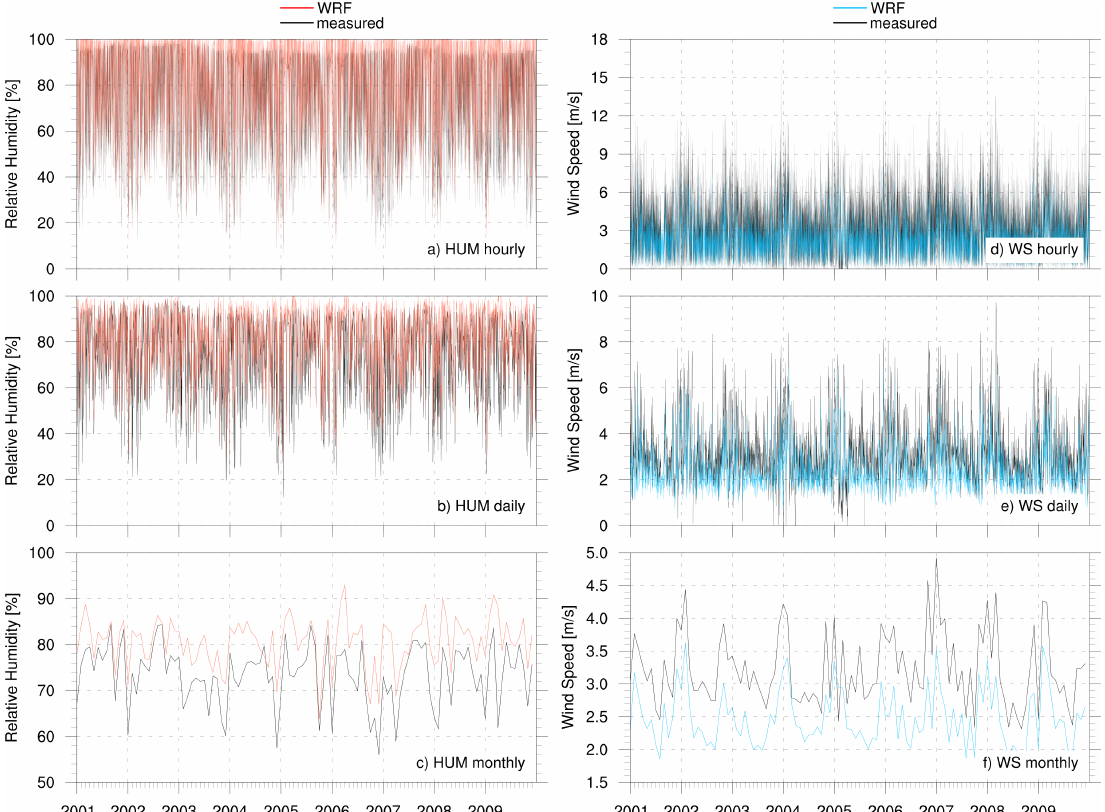
Figure 11. Relative humidity (left) and wind speed (right) modeled and measured at the station Loferer Alm (1623 m ASL) for the period 2001–2009. From top to bottom the panel shows hourly (top row), daily (center row), and monthly (bottom row) aggregated